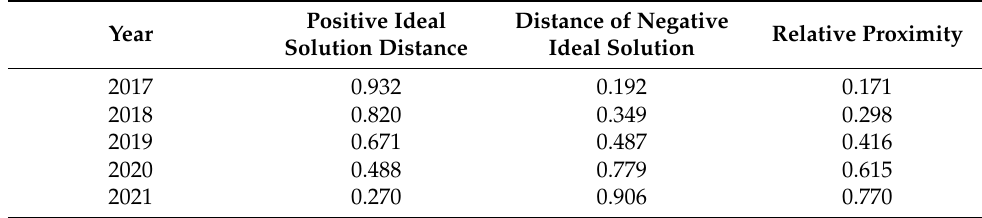
Table 6. Calculation Results of TOPSIS Green Mine Construction Assessment in